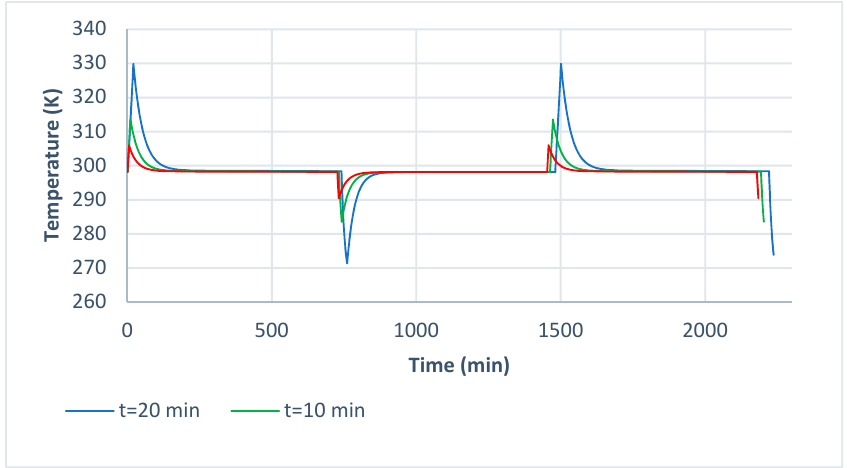
Figure 16. Gas temperature trend for the First Configuration varying the charging time.